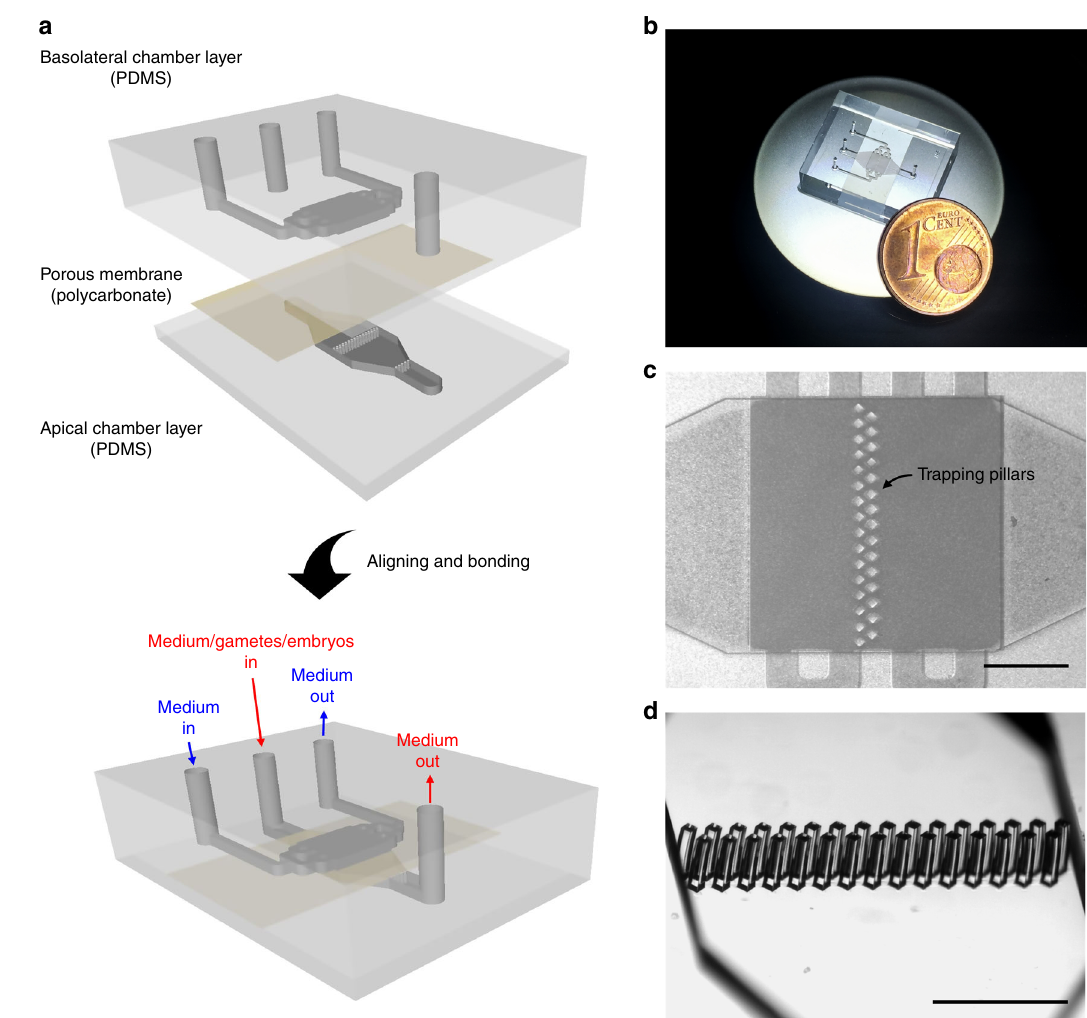
Fig. 1 Oviduct-on-a-chip platform — design and fabrication. a Schematic drawing of the apical and basolateral chambers that are assembled with a porous polycarbonate membrane between them. b Picture of an assembled PDMS device. c Microscopic picture of the assembled PDMS device, focusing on the apical culture chamber that contains the trapping pillars (TP). d Stereomicroscopic picture of the trapping pillars (W 103 μ m × L 103 μ m × H 380 μ m, spacing = 40 μ m). Scale bars = 1